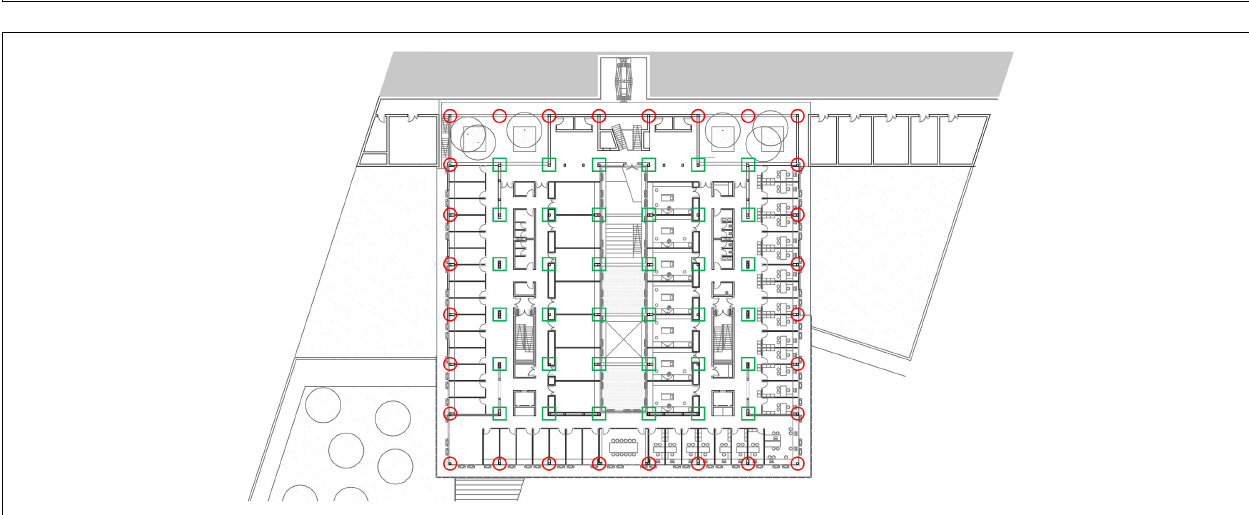
FIGURE 2 | Plan view of the building (red circles represent HDRB bearings and green squares represent flat sliders).